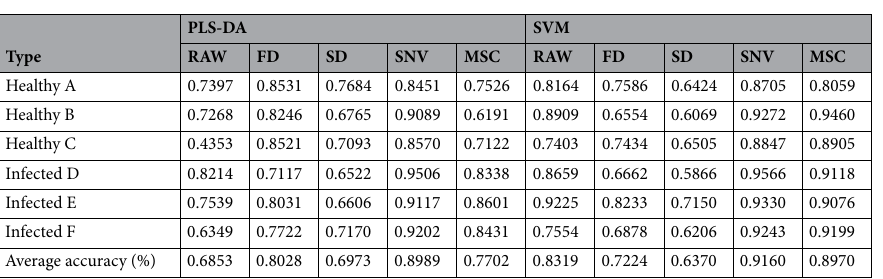
Table 2. Discriminant results of the PLS-DA and SVM models based on the full spectrum (Accuracy (%)).